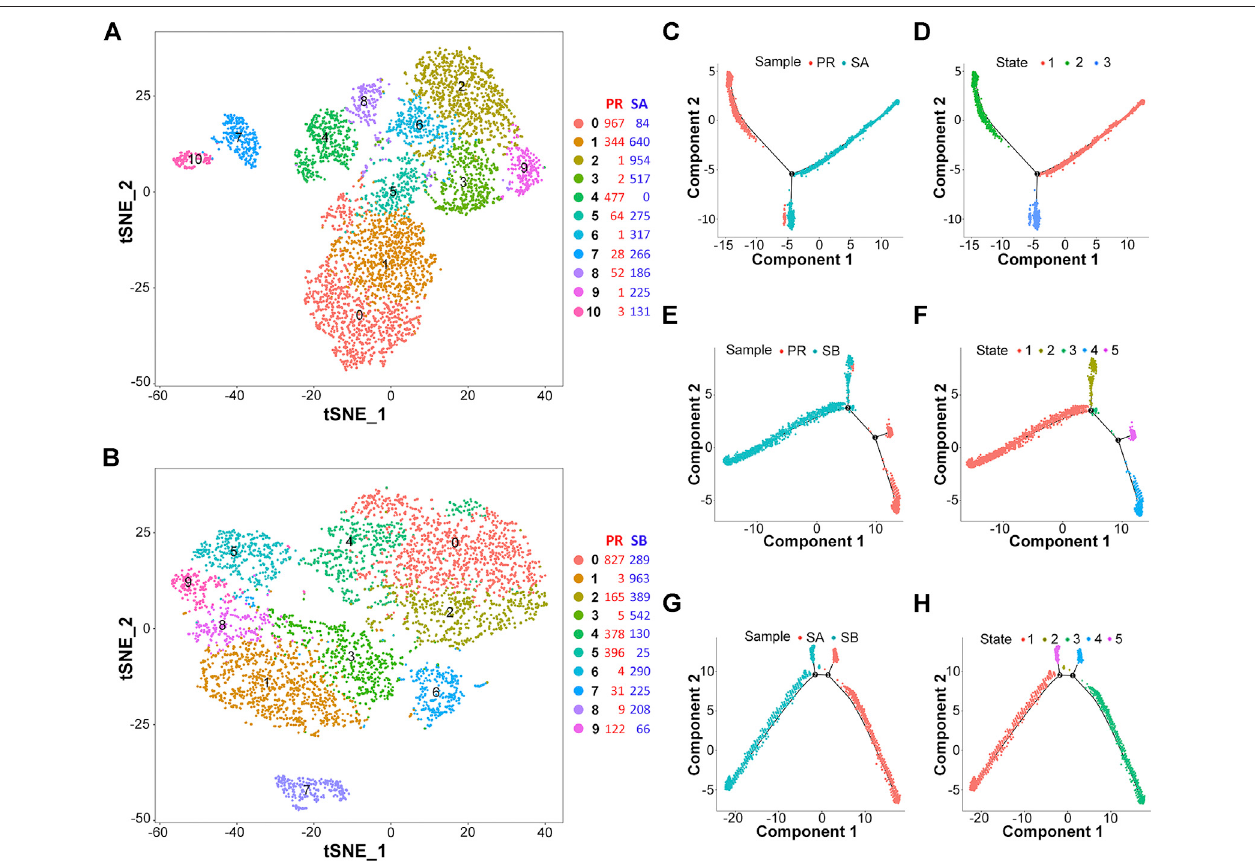
FIGURE 2 | Differentiation heterogeneity of HCC cells. (A) Two-dimensional tSNE plot depicting 5,535 single cells of PR-SA group, each classi fi ed into the 11 clusters shown with distinct colors. (B) Two-dimensional tSNE plot depicting 5,067 single cells of PR-SB group, each classi fi ed into the 10 clusters shown with distinct colors. (C – H) Pseudotime analysis of cell clusters in PR-SA/PR-SB/SA-SB groups showed a different differentiation processes.